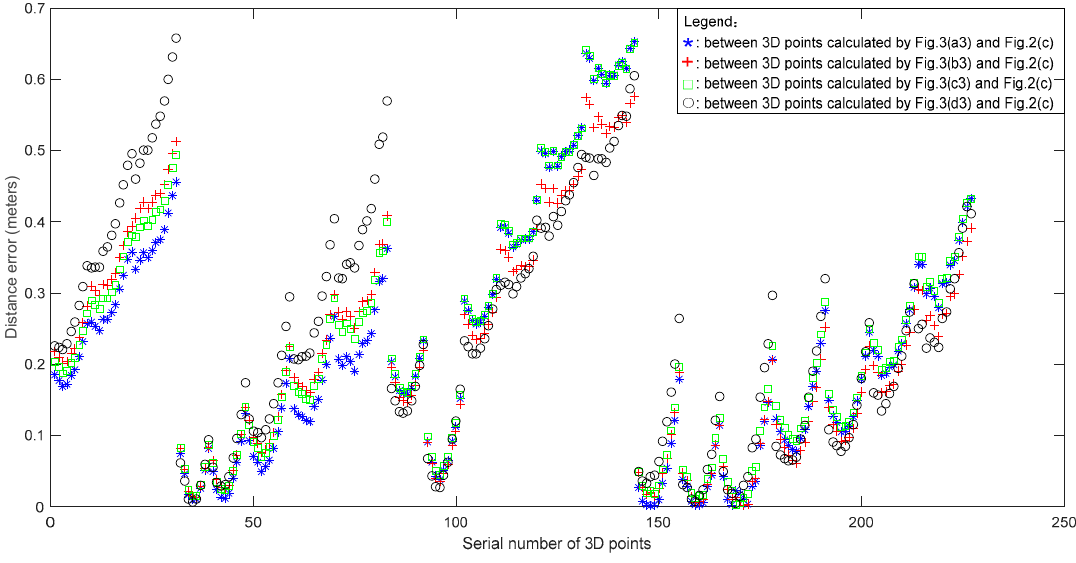
Figure 6. Distance errors of 3D points calculated by Figure 3(a3–d3) between the calculated and true values.